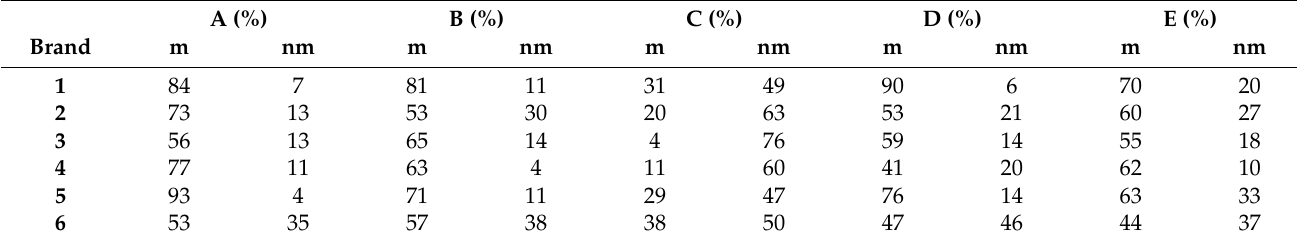
Table 1. The competence and the incompetence